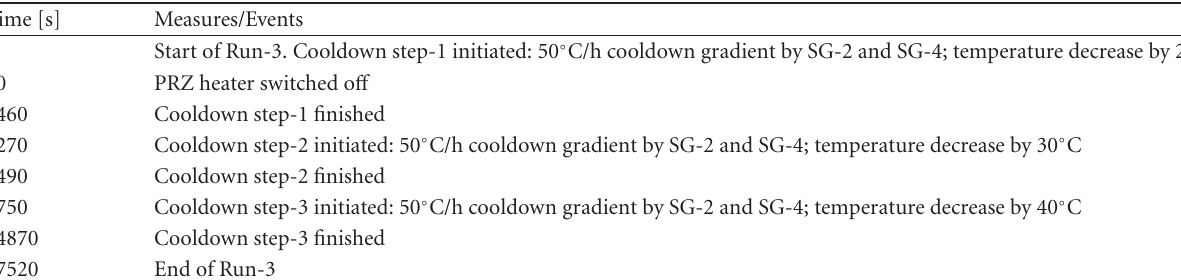
Table 5: Main events for PKL2 G2.1 Run-3.